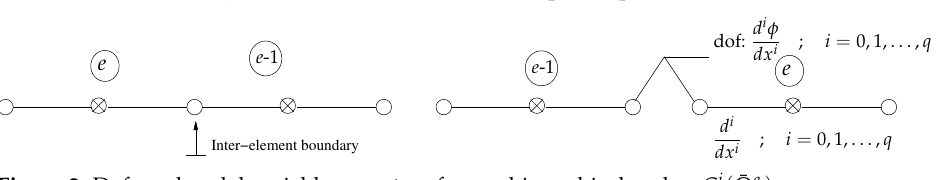
Figure 1. A three node p -version 1D element and its map in ξ space.